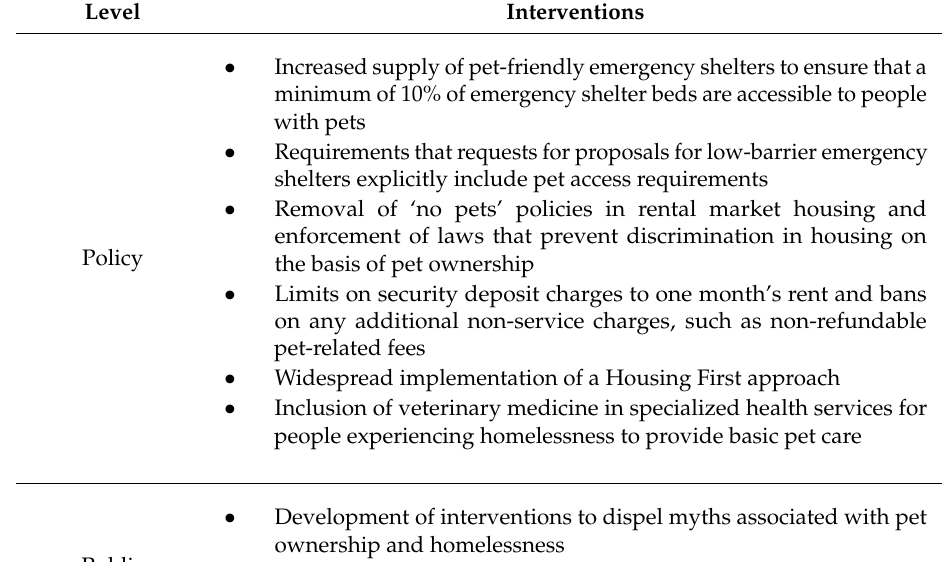
Table 1. A Multilevel Intervention Framework for Supporting People Experiencing Homelessness with